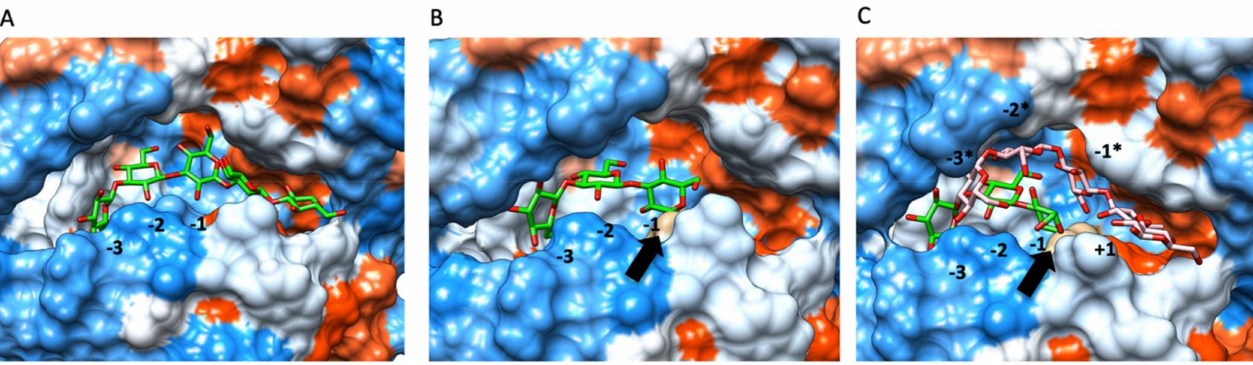
Figure 8. Complexes of Glt20 with different ligands. The hydrophobicity surfaces represent the polar residues in blue and the non-polar in red. White represent areas of intermediate polarity. Subsite amino acids: in orange ( − 3), cyan ( − 2), purple ( − 1), green (+1) and yellow (+2) ( A ) Complex Glt20-laminaripentaose (ligand in green). ( B ) Covalent intermediate Glt20-laminaritriose (in green), the covalent bond between sugar and enzyme is indicated by the black arrow. ( C ) Complex Glt20-laminaritriose (green) covalently bound and with docked laminaripentaose acceptor (in pink). Branch subsites are colored in dark pink ( − 3* and −